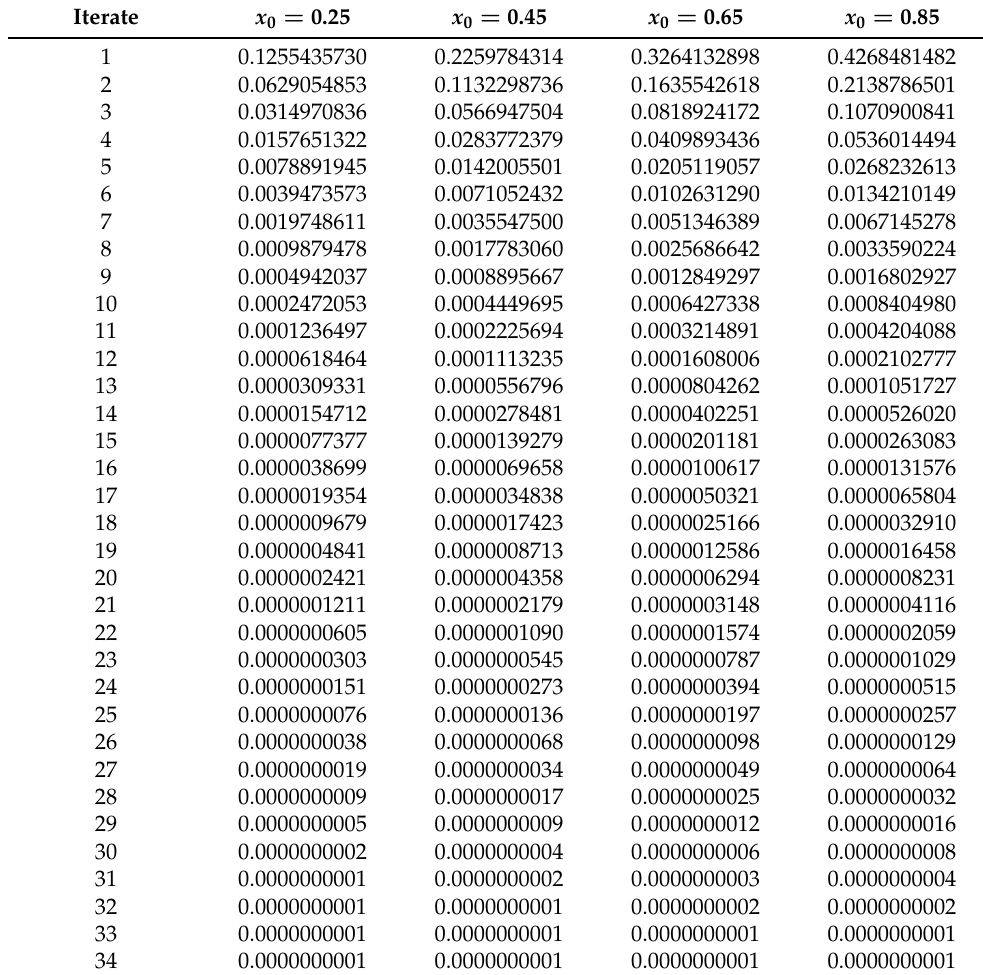
Table 1. The approximation value via the algorithm (9) in the initial point x 0